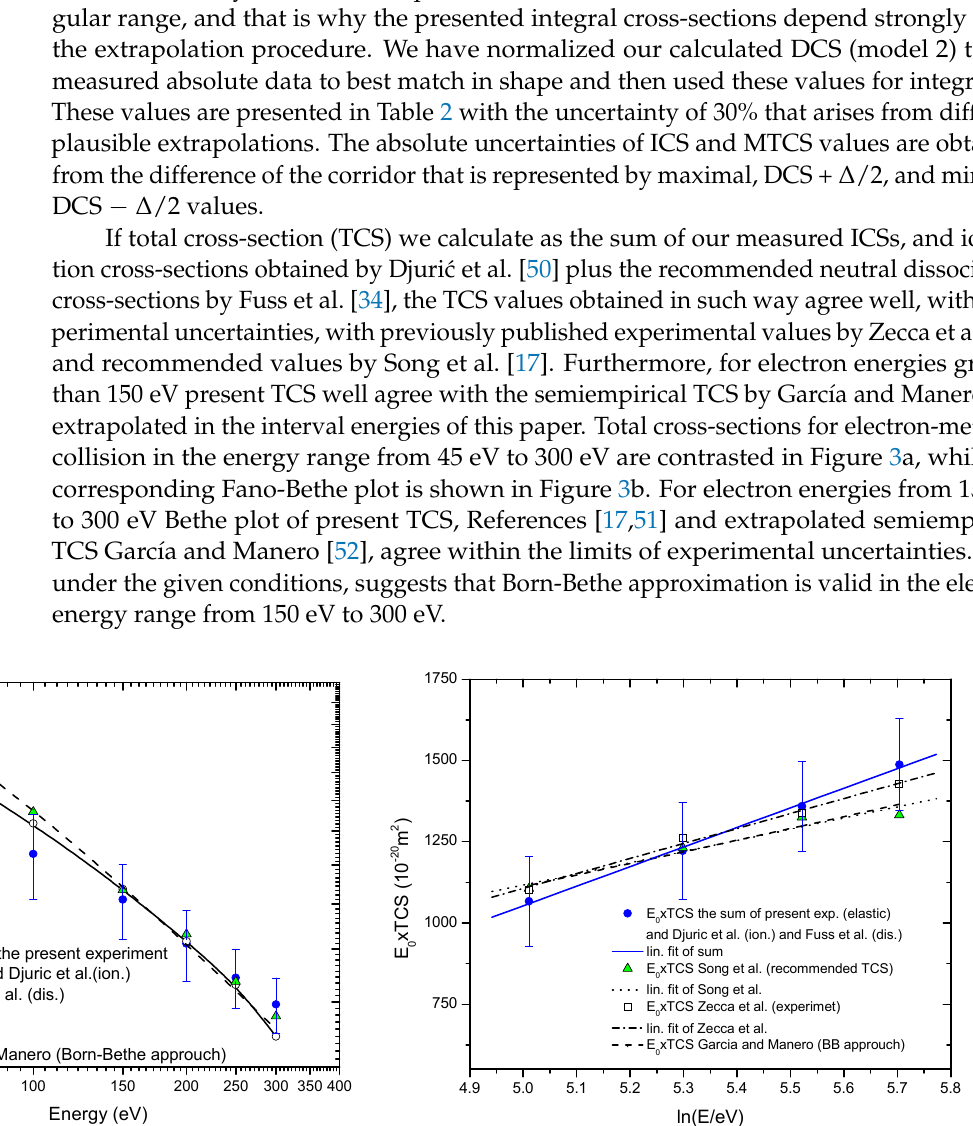
, present; , Song et al.